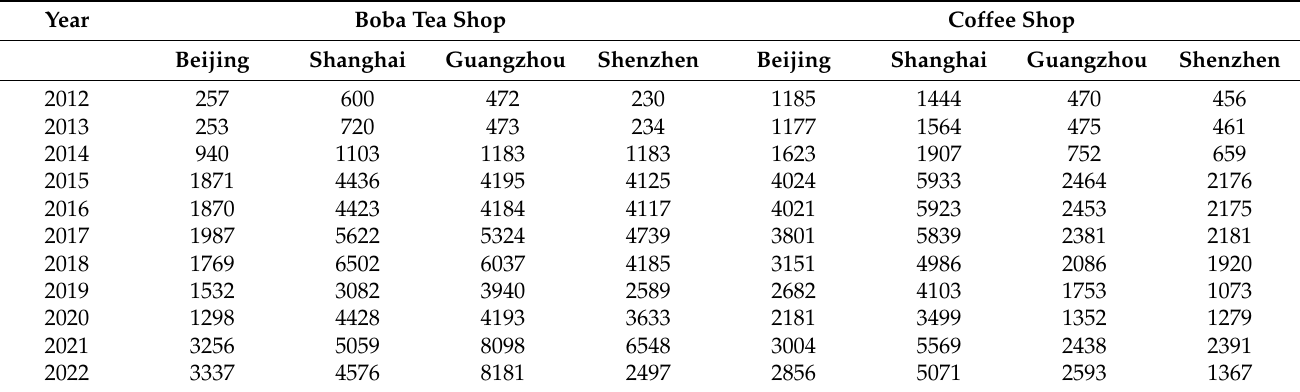
Table 2. Number of boba and coffee shops captured per year by